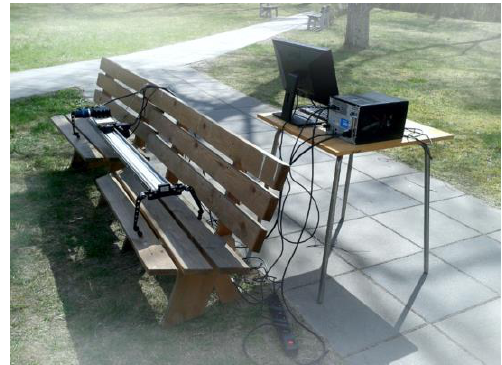
Figure 2. Example of measurement